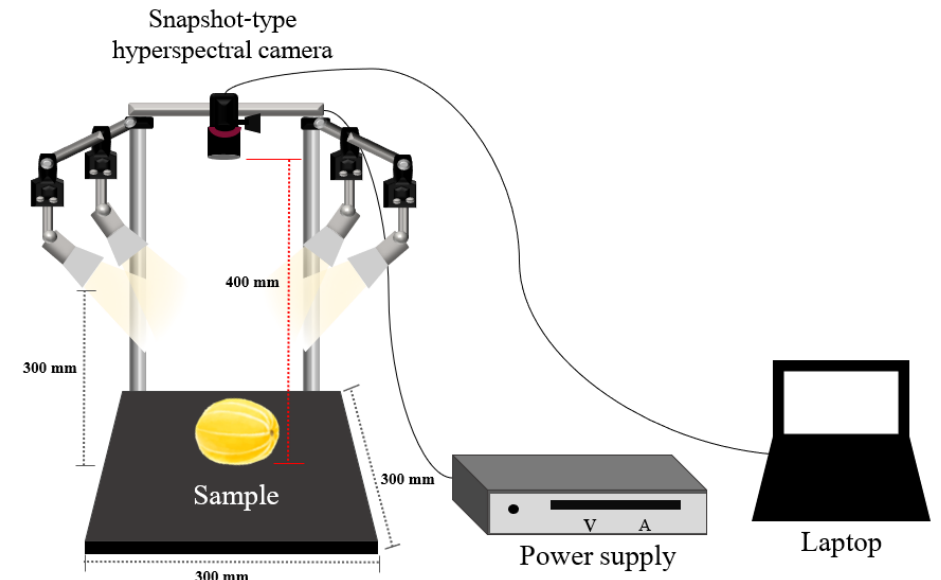
Figure 2. Schematic diagram of hyperspectral imaging system.